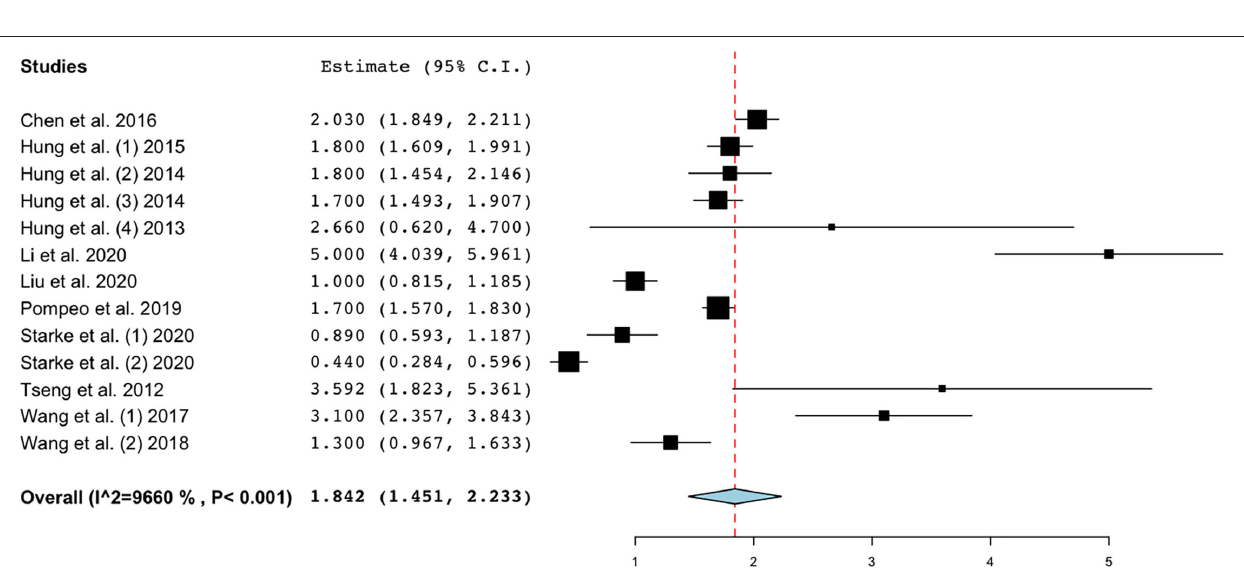
FIGURE 5 | Postoperative pain on day 1 expressed in VAS. Evaluation by all observational studies. Figure created with